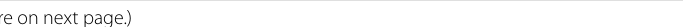
figure on next Fig. 2 The in vitro effect of siRNA against Btc on Schwann cell migration. a The transfection efficiency of siRNA- Btc . Relative abundance of Btc was summarized from three experiments. Statistical evaluation was performed using ANOVA. *p-value < 0.05 versus siRNA control. b Representative Transwell migration images and normalized averaged migration rate of Schwann cells transfected with siRNA control or siRNA- Btc . Scale bars represented 50 μm. Transwell migration assay was done three times using duplicate or triplicate wells. Statistical evaluation was performed using Mann–Whitney test. *p-value < 0.05 versus siRNA control. c Representative wound healing images and percentage decrease in scratch of Schwann cells transfected with siRNA control or siRNA- Btc . Scale bars represented 100 μm. Transwell migration assay was done four times using duplicate